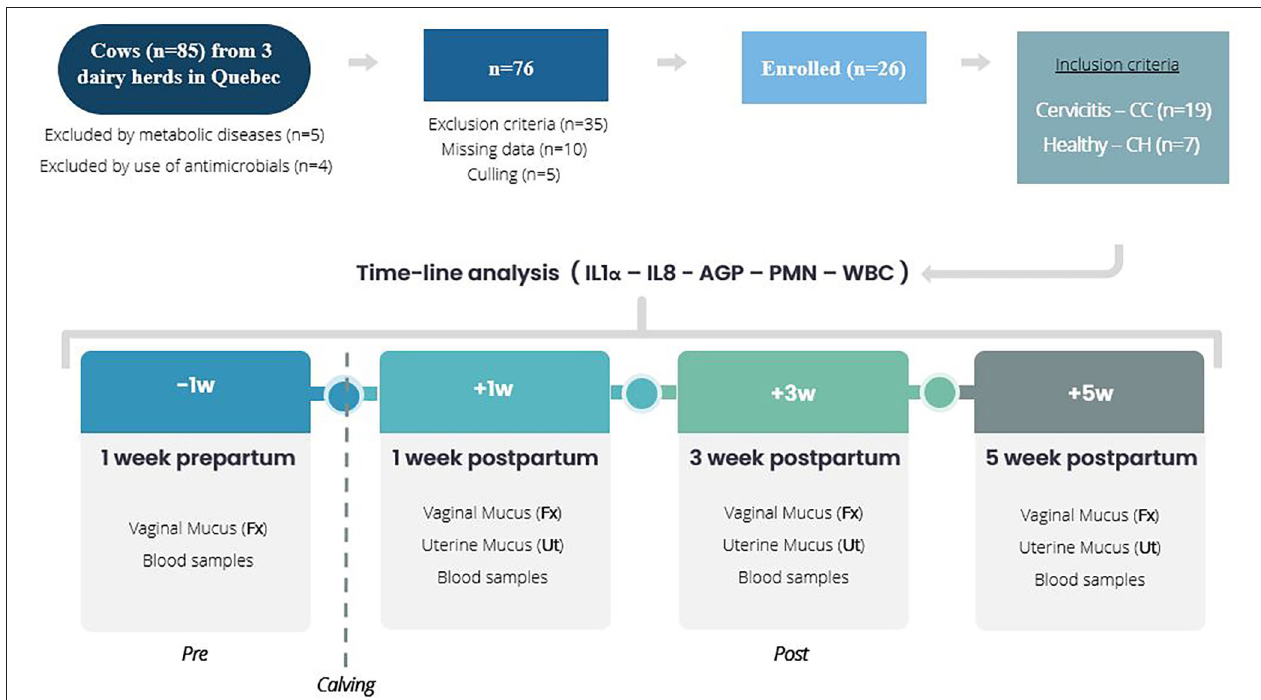
FIGURE 1 | Study design. Timeline analysis of innate immune responses of clinical cervicitis in pre- and post-partum dairy cows ( n = 26) from three dairy herds in Quebec in 2016. A retrospective study involving database and stored blood and mucus (vaginal fornix, Fx – uterine, Ut) sampling of 26 dairy cows from three commercial dairy herds in Quebec. Cows diagnosed with clinical cervicitis ( n = 19) and healthy ( n = 7) were involved in a time-course analysis from 1 week before calving to 5 weeks after calving to establish variations for white blood cell count (WBC), uterine PMN percentage, and vaginal fornix and uterine mucus cytokines (IL1 – IL8 –